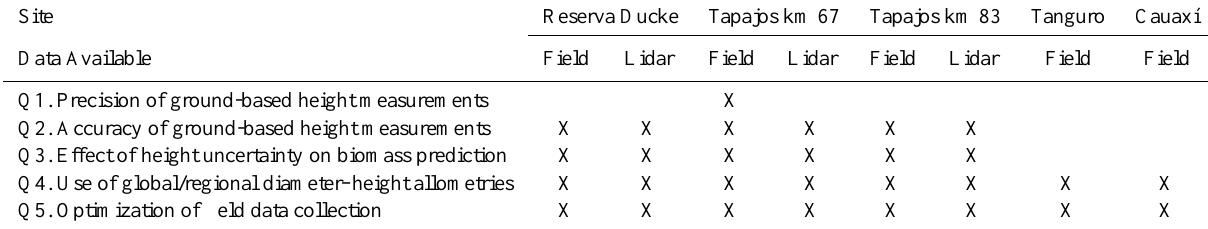
Table 1. Data used to address each of the five questions posed by this research. Lidar data were available for three of the five sites. Site Data